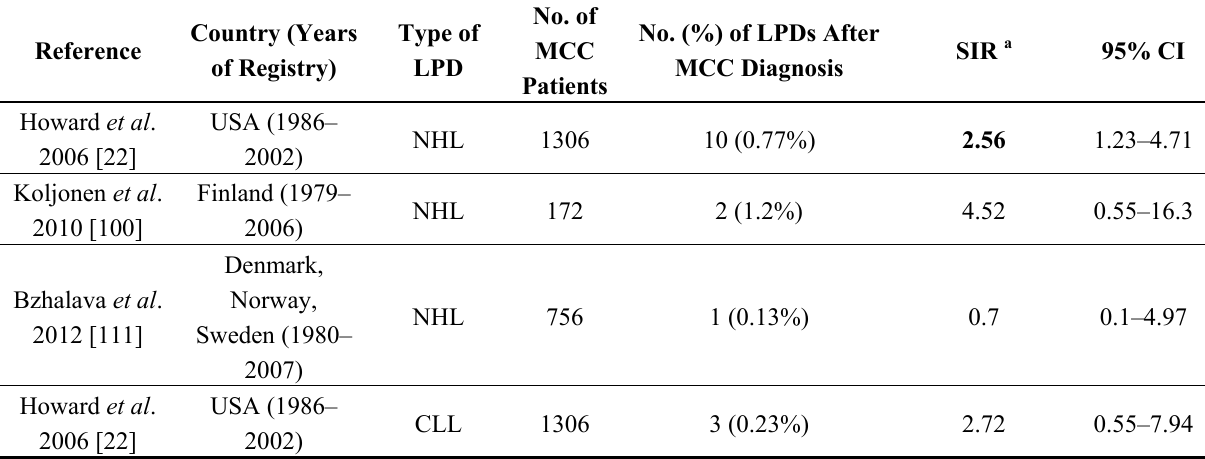
Table 2. Summary of relative risks of LPDs occurring after